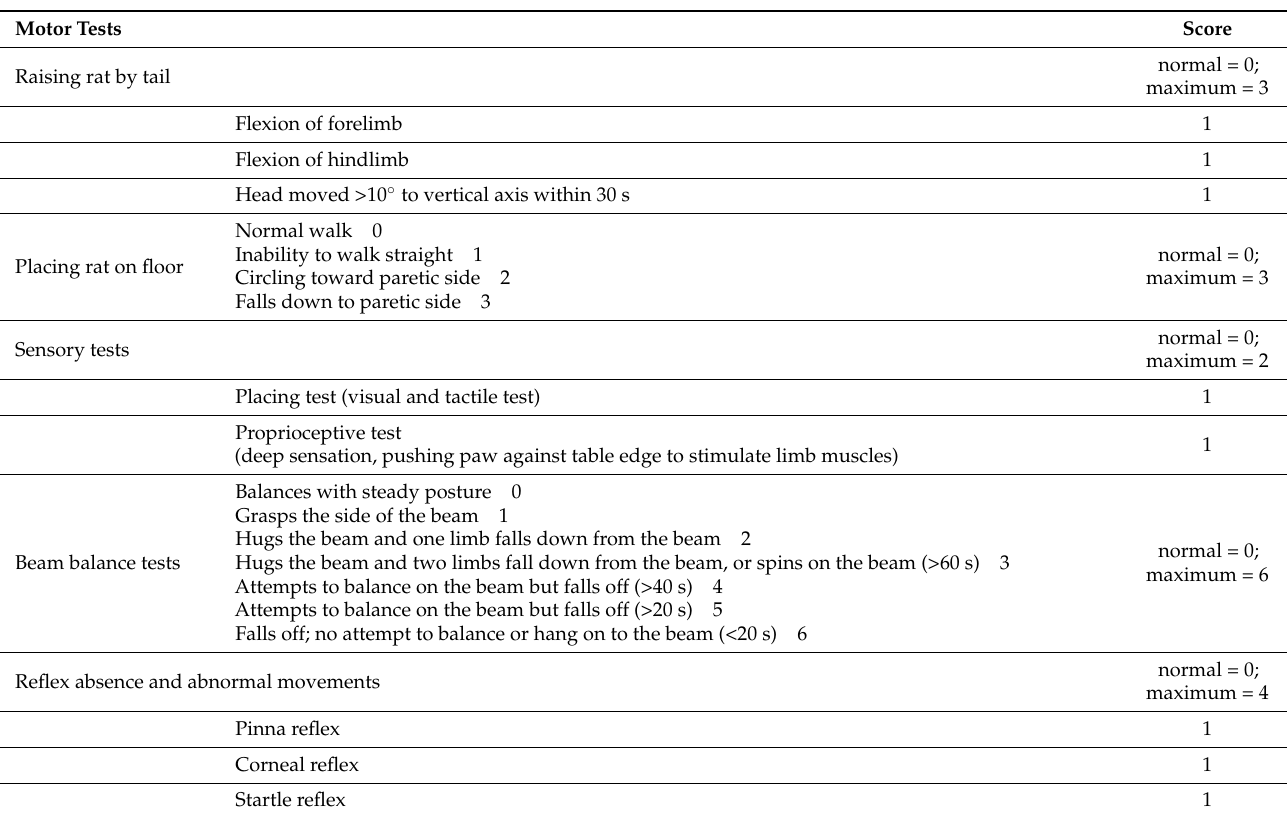
Table 1. Components of the modified neurological severity score (mNSS) and scoring